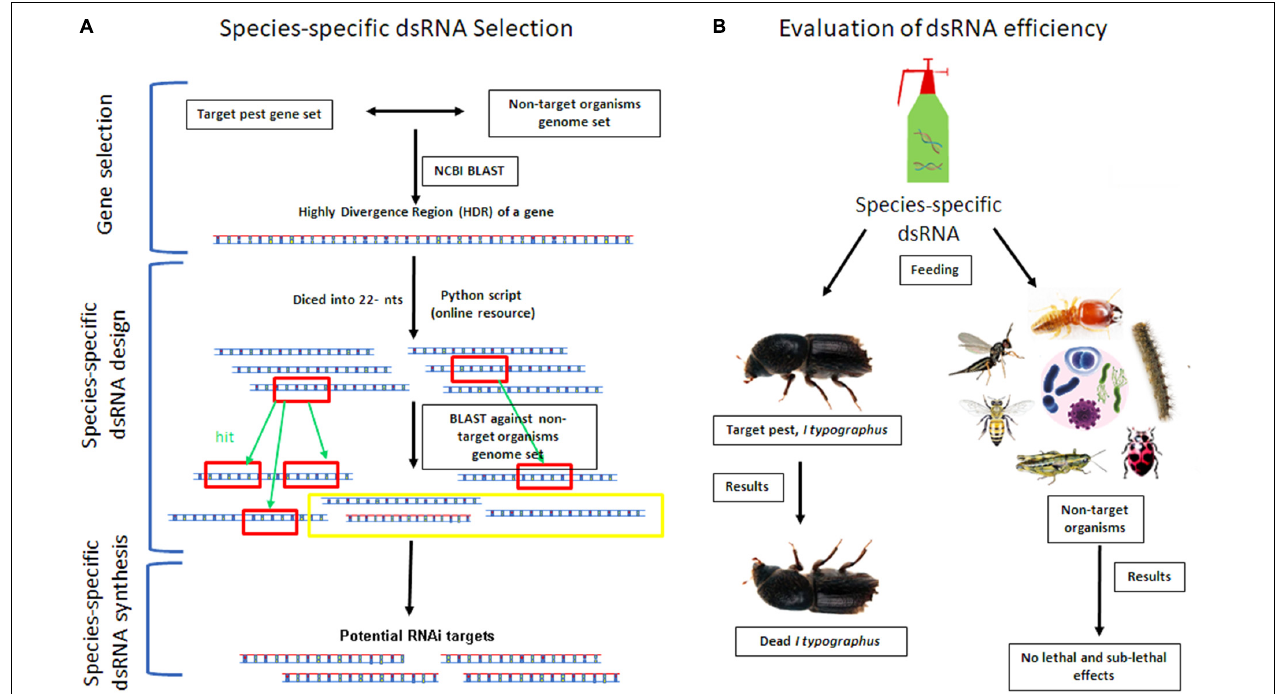
FIGURE 3 | Mitigation strategies of RNAi-based pesticides to overcome non-target effects. Schematic illustration of in silico analysis of species-specific dsRNA selection (A) and evaluation of dsRNA efficiency against the target pest and non-target organisms (B) . The selection of a target gene is a crucial step for the success of RNAi. For that, the Highly Divergence Region (HDR) of a target gene will be identified by doing NCBI BLAST of target pest gene set against the closely related non-target organism’s genome set. Subsequently, the HDR of a gene will be diced into all possible 22-nt stretches by using a python script (Online resource) (Taning et al., 2021). Afterwards, these generated 22-nt sequence stretches will be used as a query in a BLAST search against the non-target organism’s genome set for complementary sequences (hits). Finally, the sequence-specific dsRNA synthesis will be done for the identified distinct sequence region from the target gene (A) . Then, the sequence-specific dsRNA will be exposed to the target forest pest (i.e., Ips typographus ) and other non-target organisms (i.e., honeybees, wasps, butterflies, earthworms; termites, and plant-growth-promoting and soil organisms). We hypothesize that only the target pest will be affected upon feeding with